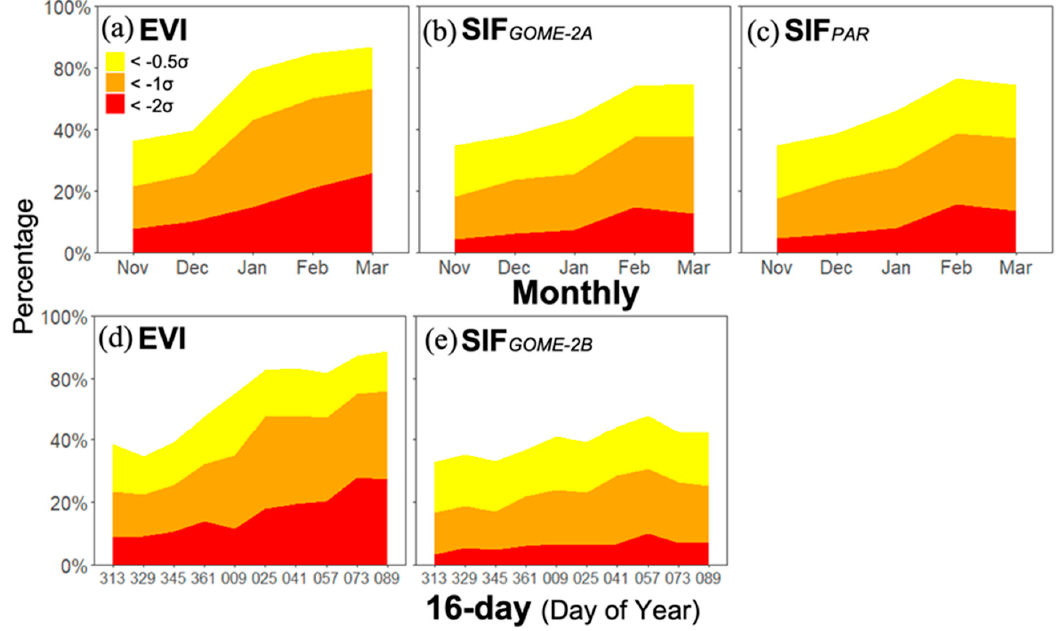
Figure 8. ( a , b , c ) Monthly and ( d , e ) 16-day time series of the percentage of drought-induced vegetation reduction indicated by EVI, SIF, and SIF PAR under moderately (< − 0.5 σ ), severely (< − 1 σ ), and extremely (< − 2 σ ) negative anomalies. σ indicates the standard deviation of the monthly SIF, EVI during 2007–2018 as well as 16-day SIF, EVI during 2013–2018. The text of the x-axis in Figure9d,e